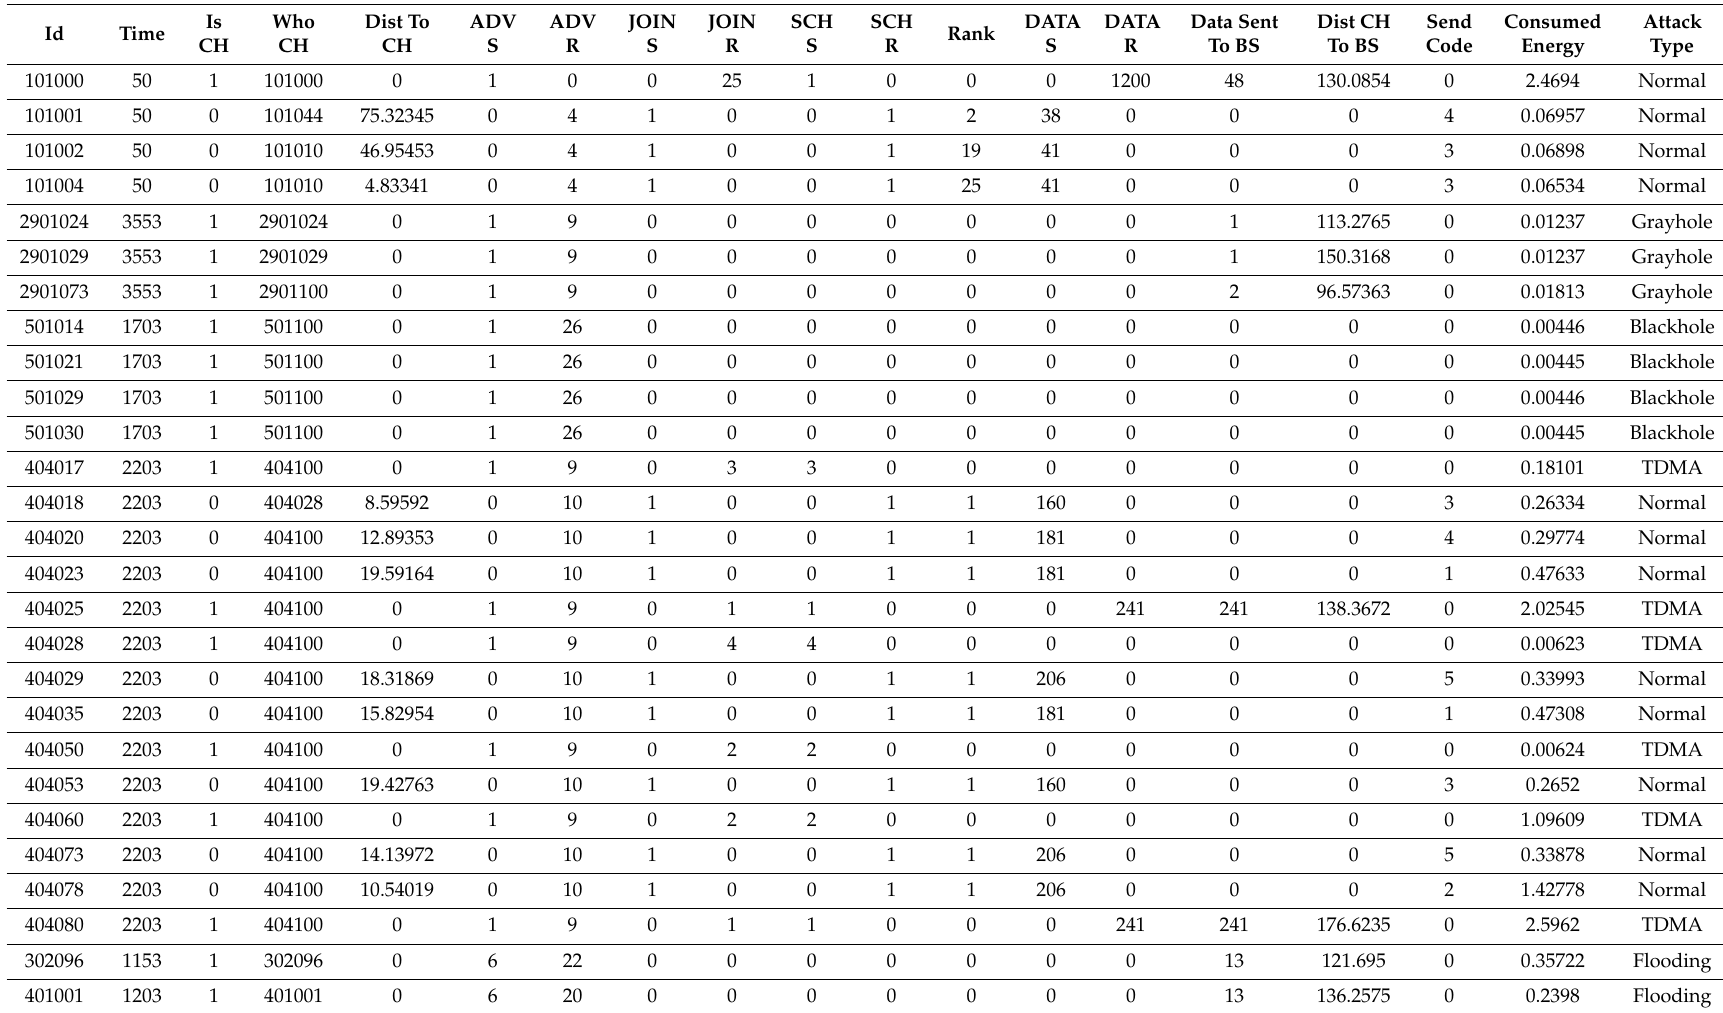
Table 2. Data samples from the WSN-DS dataset